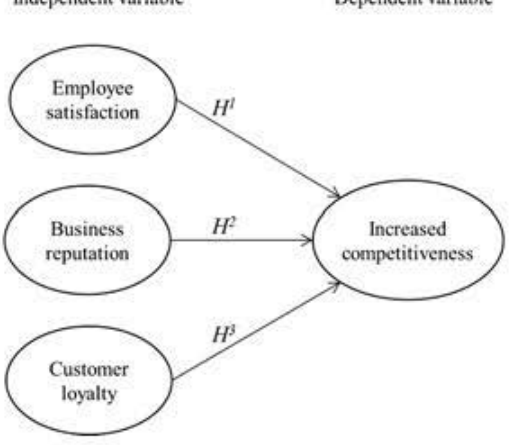
Figore 1: Delermma:nts of increased eompetitiveness of